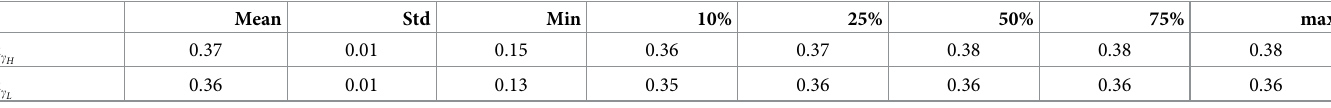
Table 1. Summary of the harvest index considering γ and γ , where final DV I � 2.0. H L Mean Std Min 10% 25% 50% 75% max 0.37 0.01 0.15 0.36 0.37 0.38 0.38 0.38 h g H 0.36 0.01 0.13 0.35 0.36 0.36 0.36 h g L